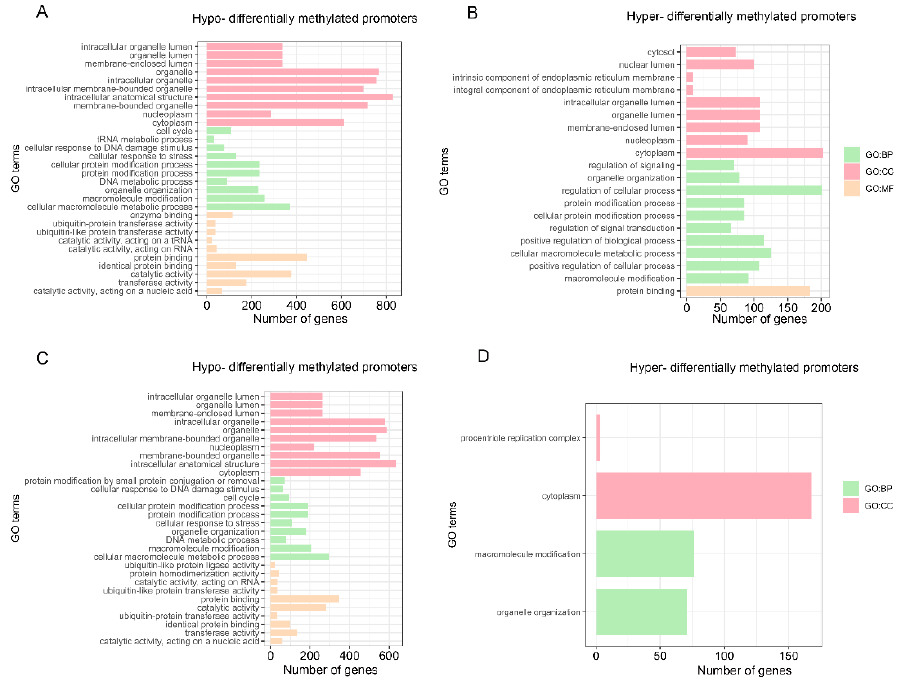
Figure 7. Significantly enriched GO categories for convergent promoters. Hypomethylated ( A ) and hypermethylated ( B ) convergent promoters of the two pandas in the stomach. Hypomethylated ( C ) and hypermethylated ( D ) convergent promoters of the two pandas in the small intestine. All Biological-process (BP), cellular-component (CC) and molecular-function (MF) categories with the top 10 most significantly enriched categories are displayed.